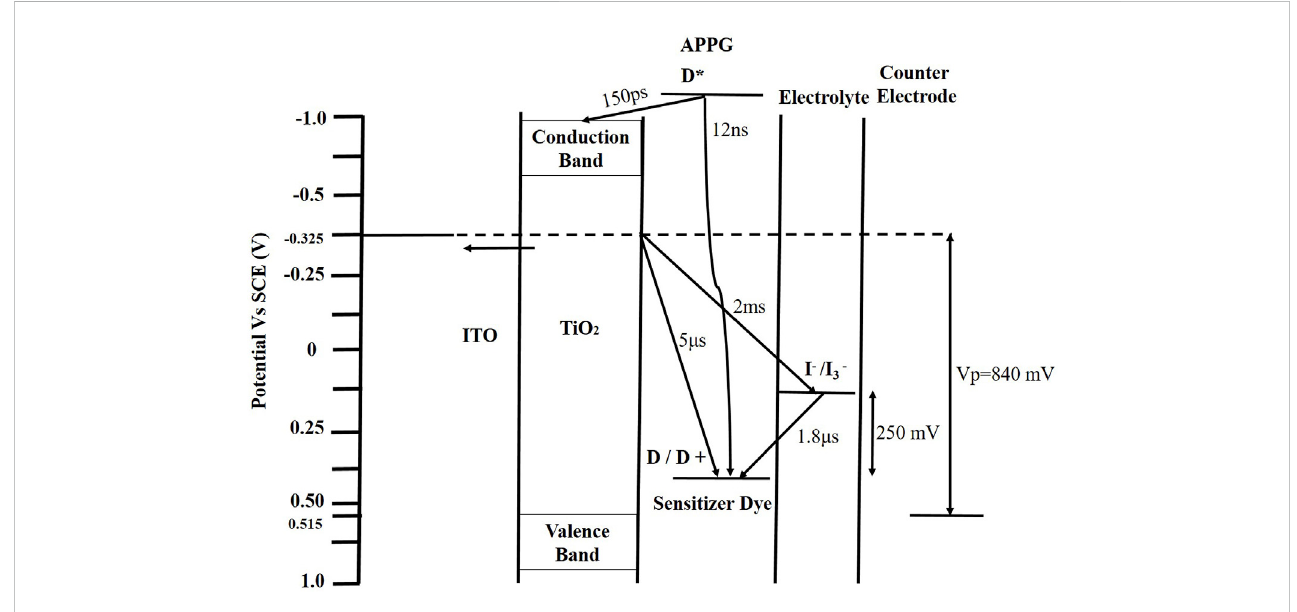
FIGURE 10 Time-scale process of electron kinetics in